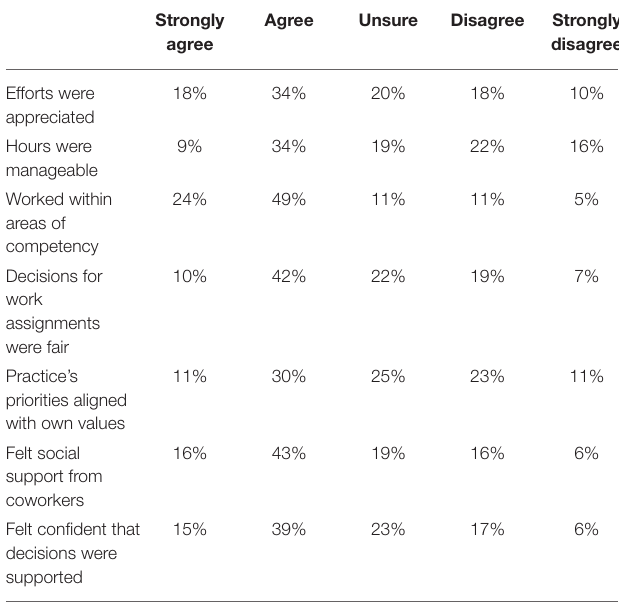
TABLE 2 | Veterinary technicians’ perceptions of their work atmosphere during